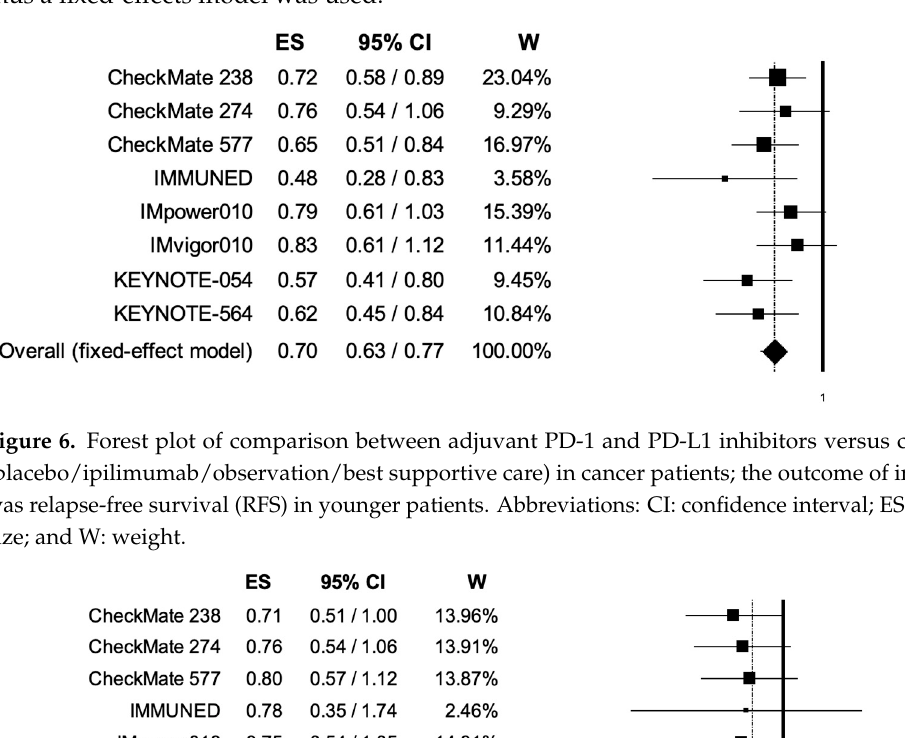
Figure 5. Forest plot of comparison between adjuvant PD-1 and PD-L1 inhibitors versus control (placebo/ipilimumab/observation/best supportive care) in cancer patients; the outcome of interest was relapse-free survival (RFS) in female patients. Abbreviations: CI: confidence interval; ES: effect size; and W: weight.